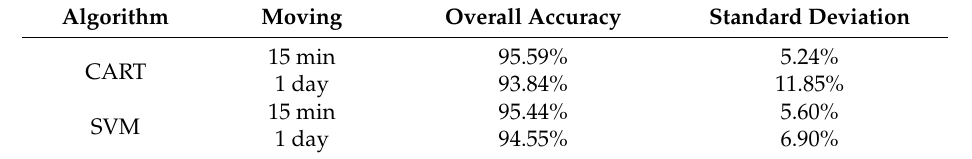
Table 9. Overall accuracy and standard deviation by classification algorithms and window moving intervals.